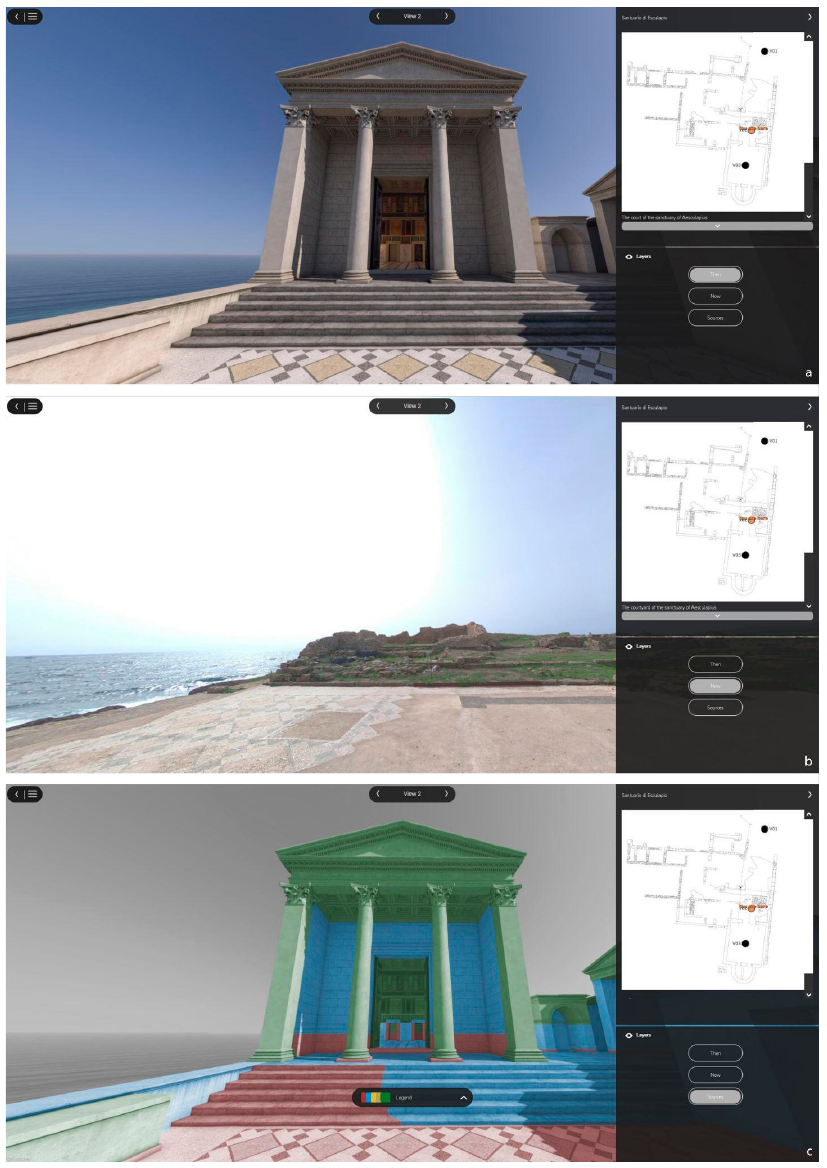
Figure 11. e-Archeo 3D: ( a ) display level ‘Then’ of the Venus Sanctuary at Nora; ( b ) display level ‘Now’ of the current state of the archaeological area; ( c ) display level “Sources” of the Venus Sanctuary at Nora (by Progetto Katatexilux).